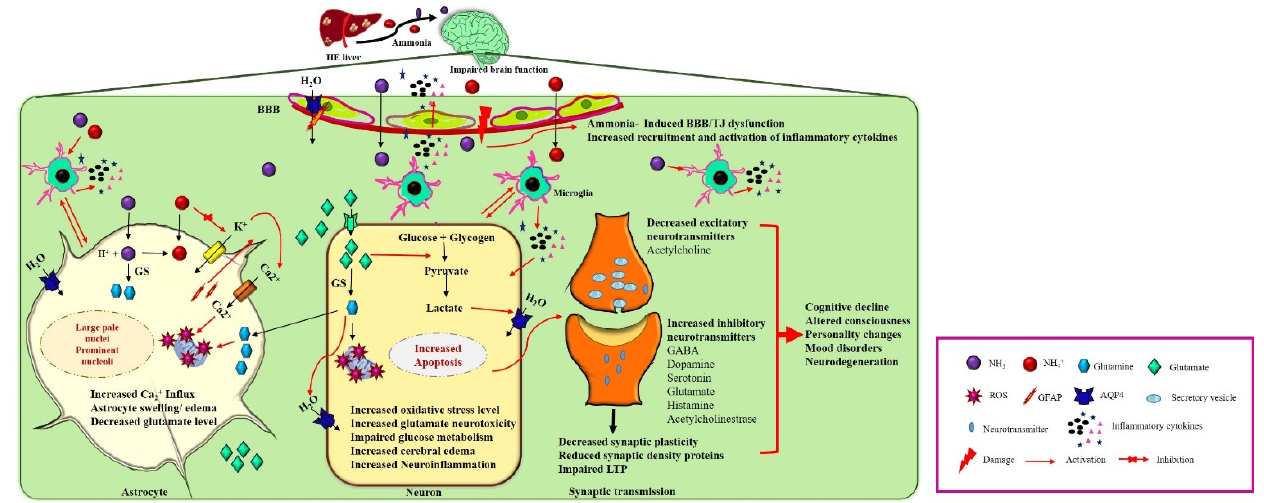
Figure 1. Neuropathogenesis of HE on brain dysfunction . HE liver releases excess nitrogenous toxin (NH 3 , NH 4+ ) that enters cerebral circulation. Ammonia can cross the BBB and trigger the other pathological response such as activation of aquaporin water channels and damage of BBB’s tight junctions. Astrocytes detoxify ammonia to form glutamine from glutamate by glutamine synthase (GS). Excess glutamine production increases oxidative stress, aquaporin channels’ activation, increases Ca 2+ influx and GFAP production, and decreases glutamate uptake leading to accumulation of glutamate into the extracellular fluid. Activation of water channels, increased Ca 2+ influx, and increased glutamine secretion cause astrocyte swelling. On the other hand, accumulated extracellular glutamate enters into neurons, causing glutamate neurotoxicity. Intracellular glutamate impairs glucose metabolism, activates microglial inflammatory cytokines, increases oxidative stress, and inhibits mitochondrial functions, leading to decrease in excitatory neurotransmitters synthesis and release into the synapses. In synaptic transmission increases synthesis and release of inhibitory neurotransmitters impairing the LTP, synaptic plasticity, and reducing synaptic density proteins, leading to cognitive decline and other neuropsychiatric illnesses.